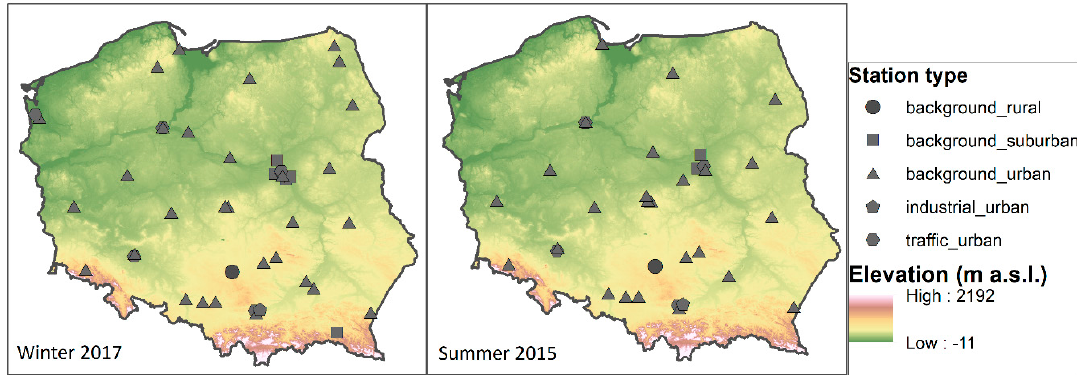
Figure 2. Location of surface observations for the winter (left) and summer seasons (right) over Poland. Station types shown by signatures. Elevation in meters above sea level (m a.s.l.)